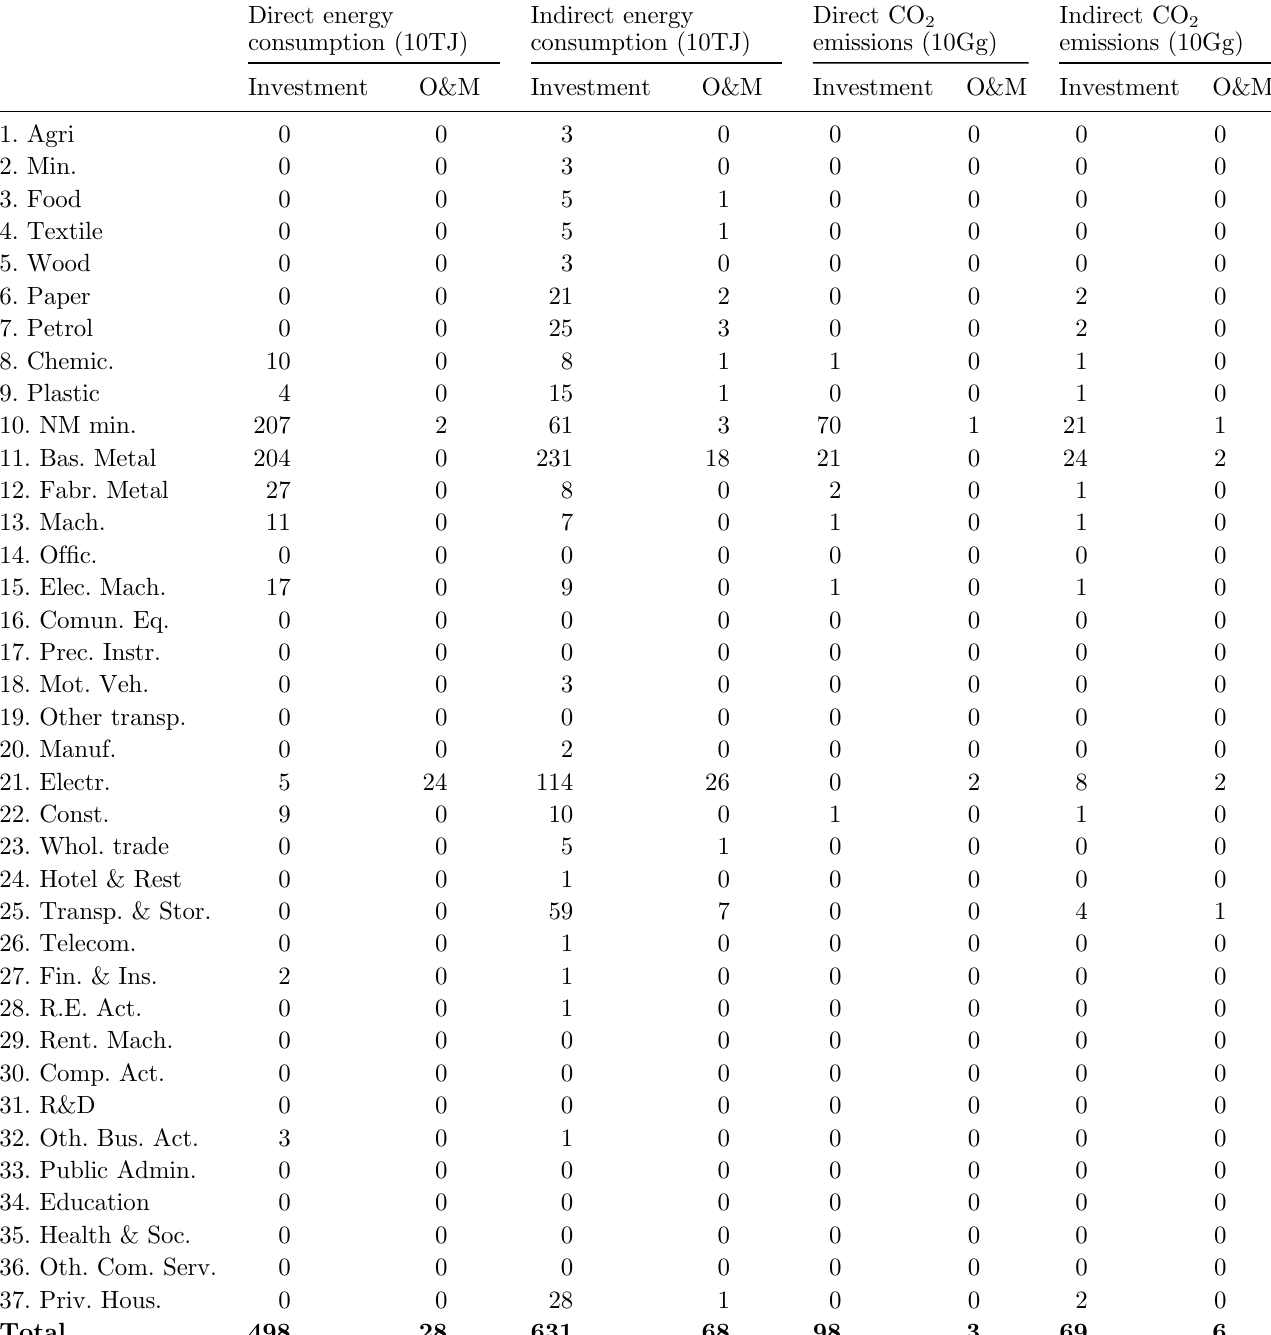
emissions in the whole plant 2